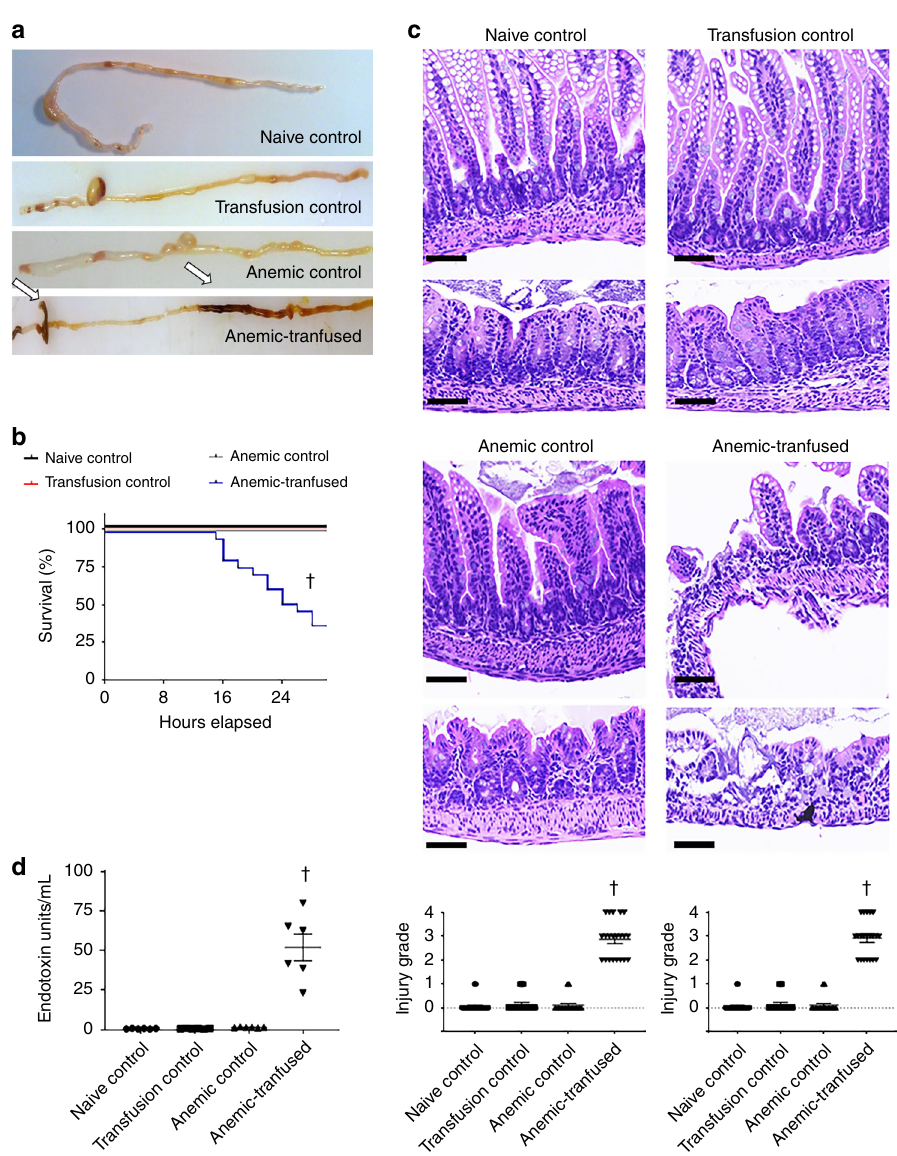
Fig. 2 Red blood cell (RBC) transfusions trigger necrotizing enterocolitis (NEC)-like injury in anemic pups. a Representative photographs show bowel injury in ileocecal and mid-colonic regions (arrows) in anemic-transfused animals. Naive control, transfusion control, and anemic control did not develop bowel injury. b Kaplan – Meier curves summarize survival without intestinal injury; Mantel – Cox log-rank test, † P < 0.001. c Representative photomicrographs (hematoxylin – eosin; magni fi cation ×250) of ileum (left) and colon (right) show NEC-like injury in anemic-transfused mice. Scale bars = 100 µ m. Scatter plots summarize severity of bowel injury. N = 42 animals in naive control, 21 in transfusion control, 18 in anemic control, and 21 in anemic-transfused groups. d Scatter plots show plasma lipopolysaccharide (LPS) levels in the four groups; N = 6 mice per group; Kruskal – Wallis H test with Dunn ’ s post test, † P < 0.001 vs. naive control. All scatter plots summarize the data as means ± standard error of the